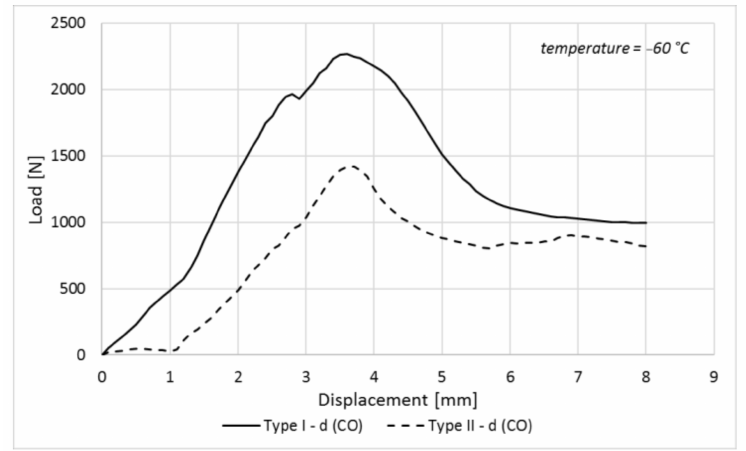
Figure 18. Closing force curves were obtained for − 60 ◦